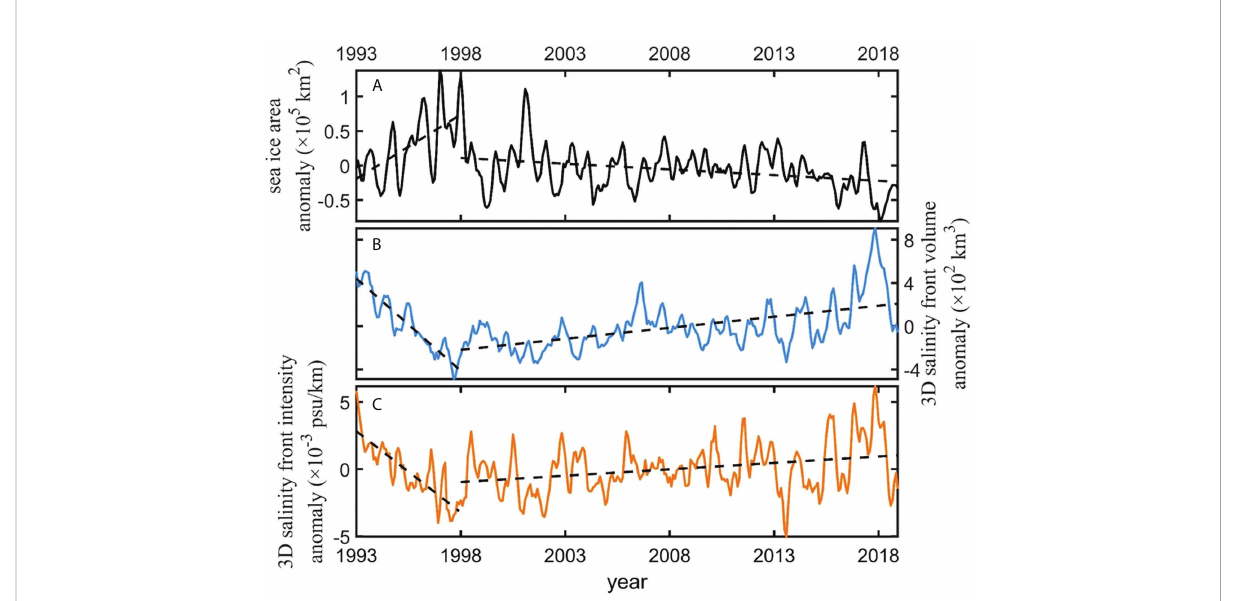
FIGURE 9 Long-term trend from GLORYS12v1 data. (A) Monthly sea ice area anomaly, (B) 3D salinity front volume anomaly, and (C) intensity anomaly. All lines are fi ltered by three (months) points moving average.